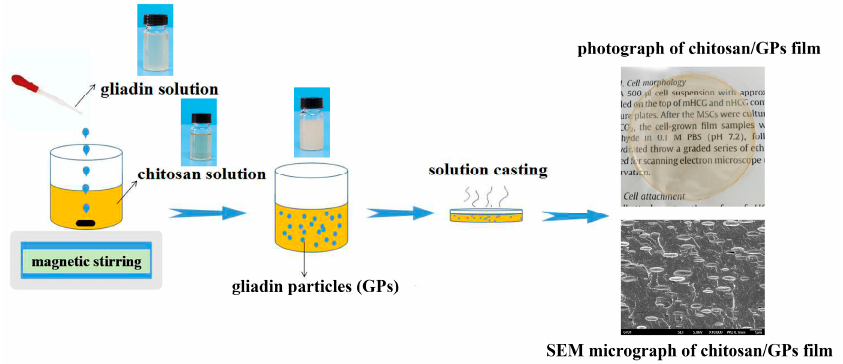
Figure 1. Schematic of fabrication mechanism of chitosan/gliadin particles (CS/GPs) biocomposites.